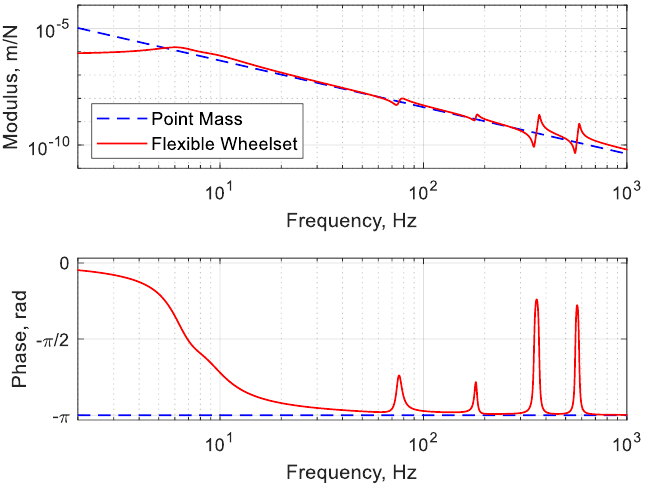
Figure 2. Direct vertical receptance of the wheel derived with point mass and flexible wheelset model.